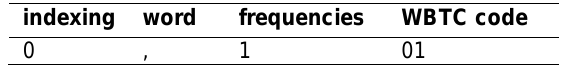
Table 5: Word-frequency table for length one